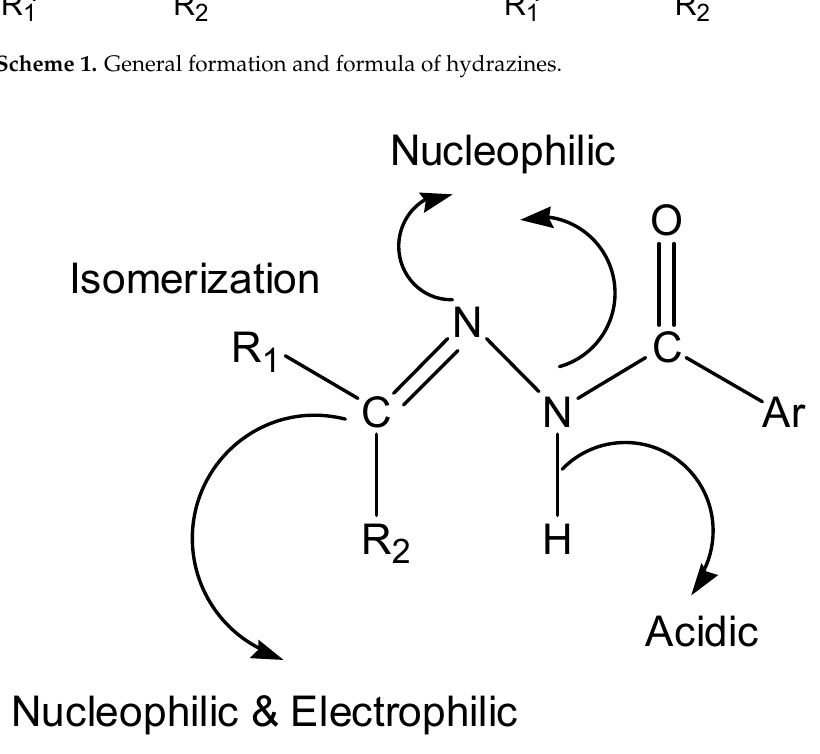
Figure 1. The structural and functional diversity of the hrdrazone group.